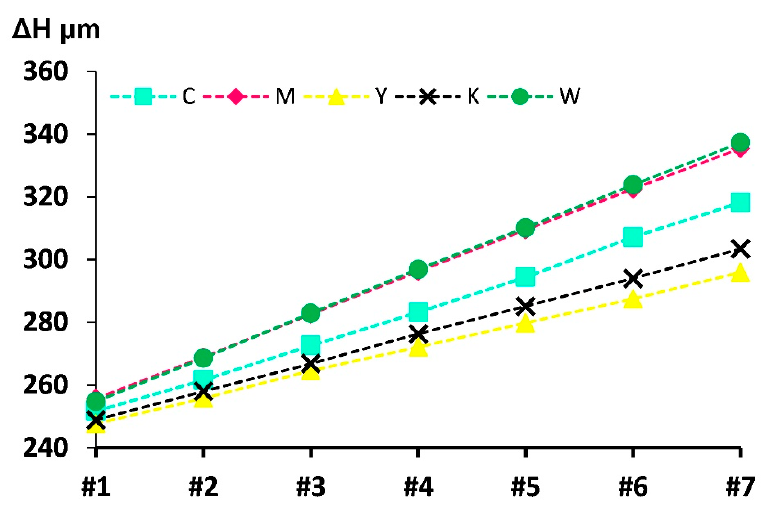
Figure 4. A diagram to quantify the printed ink thickness and successive layers.